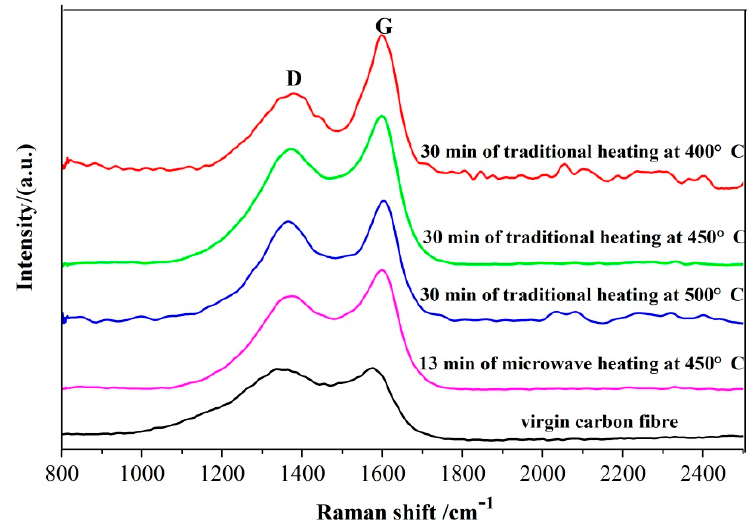
Figure 7. ( a ) XRD spectra of the (002) plane of carbon fibers, ( b ) XRD spectra of the (101) plane of carbon fibers.